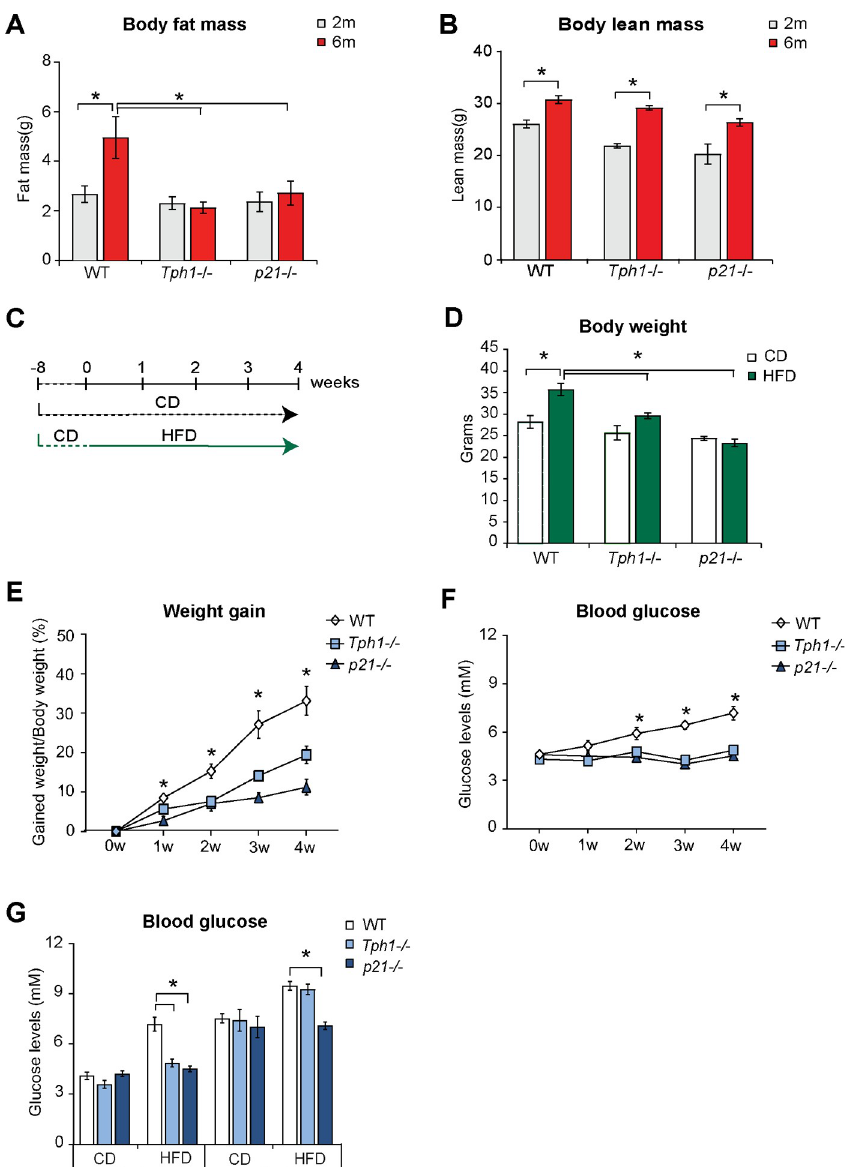
Fig 5. Ablation of Tph1 or p21 limits early adulthood-associated fat mass accumulation and prevents high fat diet-induced weight gain. (A) EchoMRI quantification of whole body fat mass in wild type (WT), Tph1 deficient ( Tph1 -/- ) and p21 deficient ( p21 -/- ) mice at 2 and 6 months of age. (B) EchoMRI quantification of whole body lean mass in WT, Tph1 -/- and p21 -/- mice at 2 and 6 months of age. (C) Schematic representation of diet regimens using normocaloric standard chow diet (CD) and hypercaloric high fat diet (HFD). (D) Body weight of WT, Tph1 -/- and p21 -/- mice fed CD or HFD for 4 weeks. (E) Body weight gain, expressed as percentage of initial body weight, of WT, Tph1 -/- and p21 -/- mice during 4 weeks of HFD. (F) Blood glucose levels of WT, Tph1 -/- and p21 -/- mice during 4 weeks of HFD. (G) Comparison of blood glucose levels in fasted or fed state of WT, Tph1 -/- and p21 -/- mice after 4 weeks of CD or HFD. Results are average ± SEM (n � 5), � p <